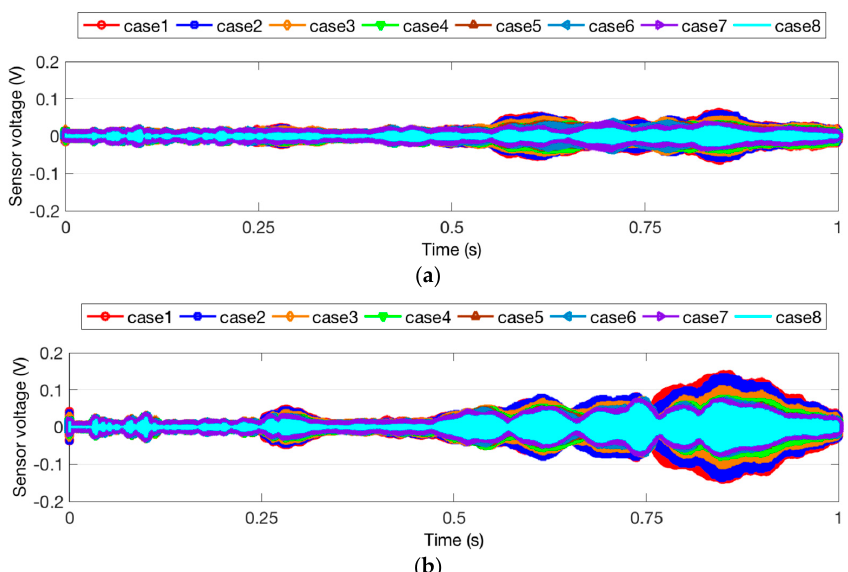
Figure 4. Sensor signal response for Group A. ( a ) Specimen 1; ( b ) Specimen 2.